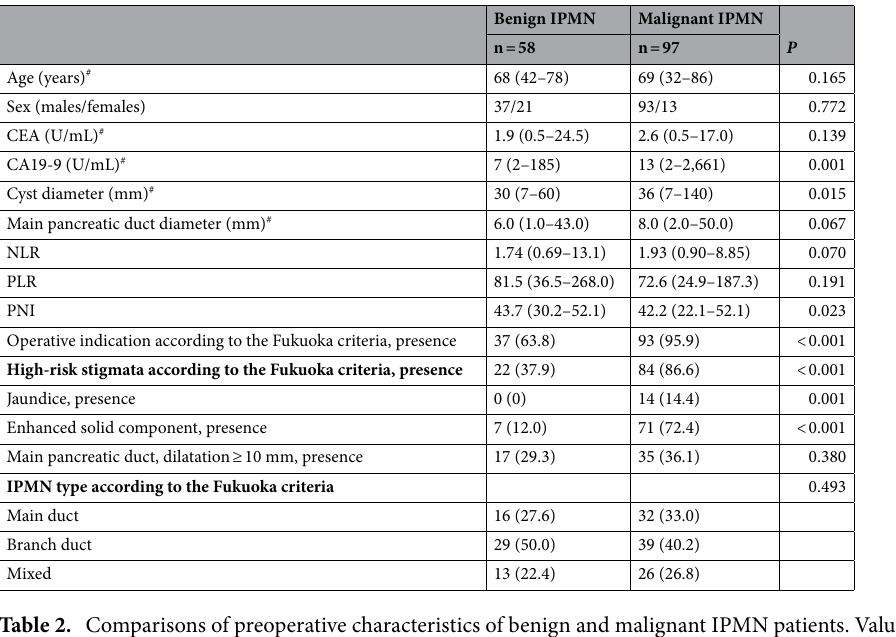
Table 2. Comparisons of preoperative characteristics of benign and malignant IPMN patients. Values in parentheses are percentages unless otherwise indicated. Values are shown as the # median (range). IPMN